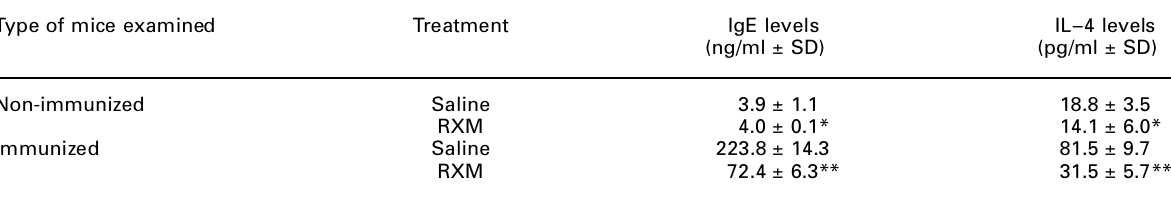
Table 1. Influence of roxithromycin (RXM) on IgE production and IL–4 appearance in BALB/c mice immunized with DNP-OVA mixed with Al(OH) 3 Type of mice